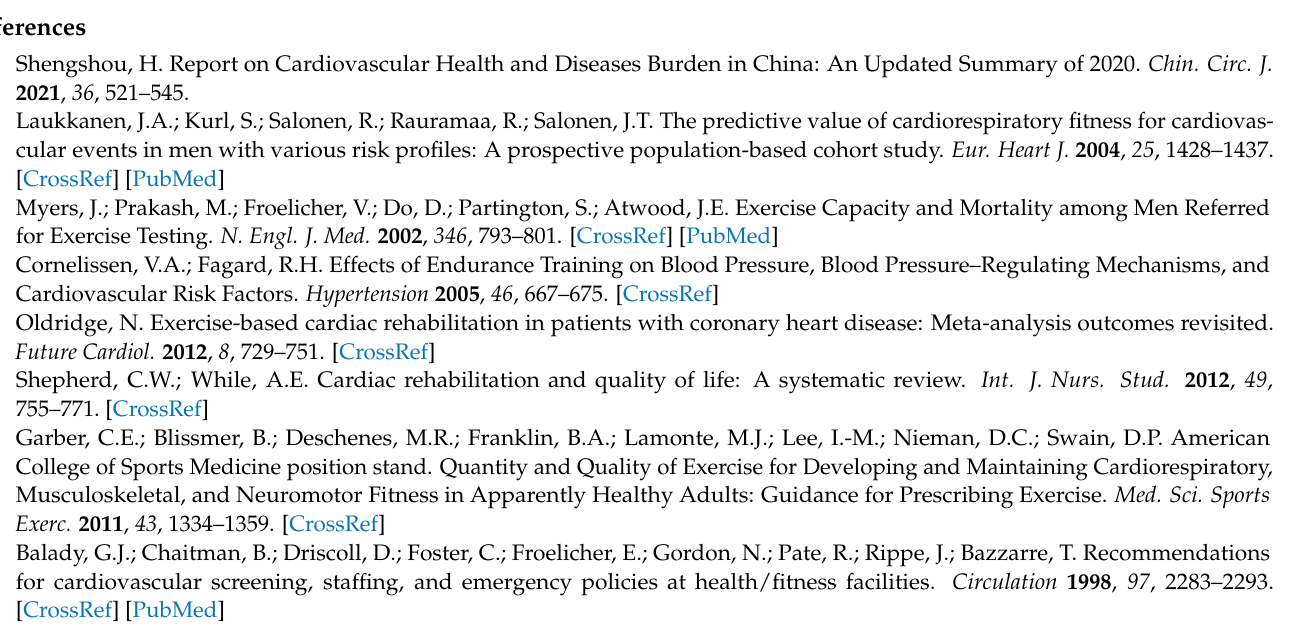
Table S1: Systematic literature search, Table S2: Intervention details. Table S3: Subgroup analyses of effects of HIIT versus MICT on VO 2peak